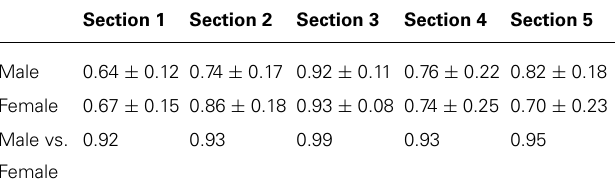
Table 2 | Correlation coefficients for the CWT-F variables for both male and female